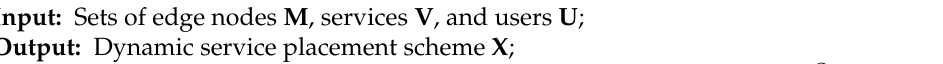
Algorithm 2 Dynamic service placement based on